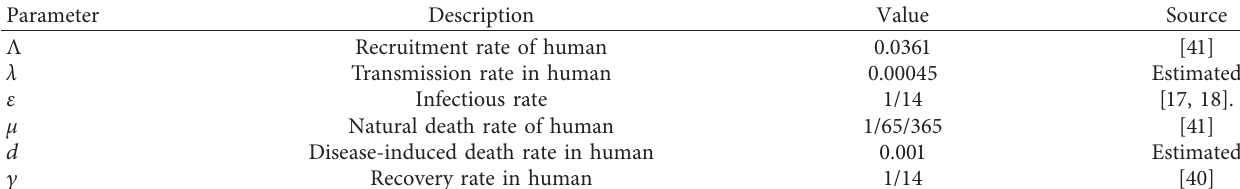
Table 2: Parameters and their